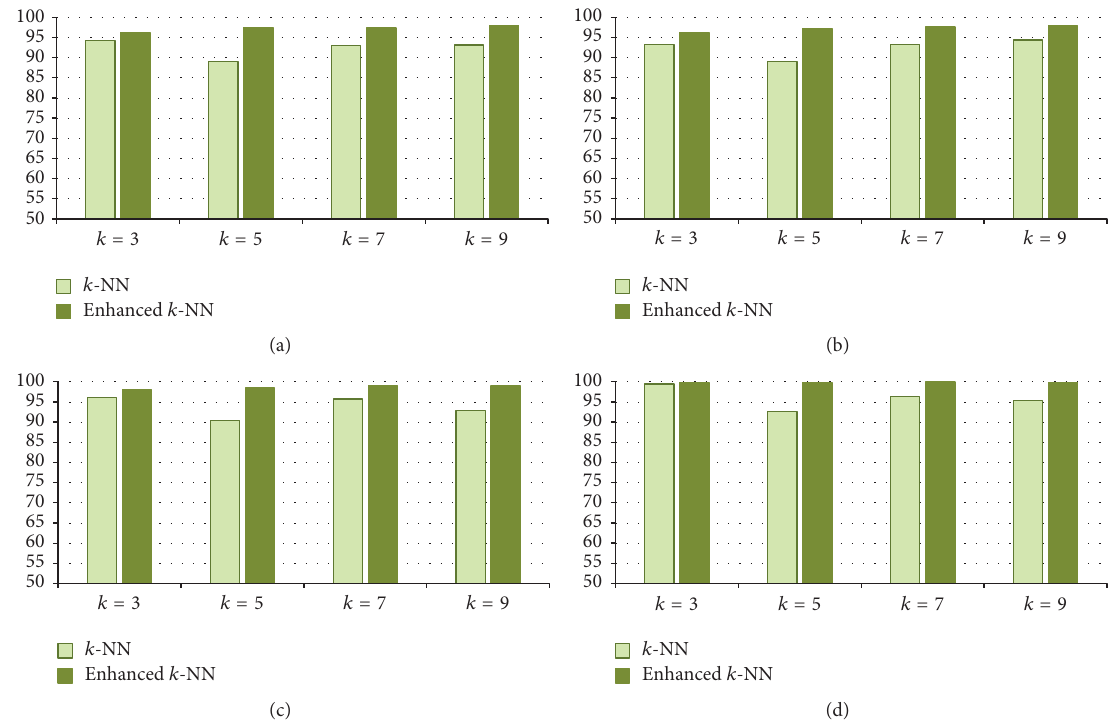
Figure 11: Performance comparison of traditional k -NN and the proposed enhanced k -NN in terms of average classification accuracy: (a) dataset 1, (b) dataset 2, (c) dataset 3, and (d) dataset